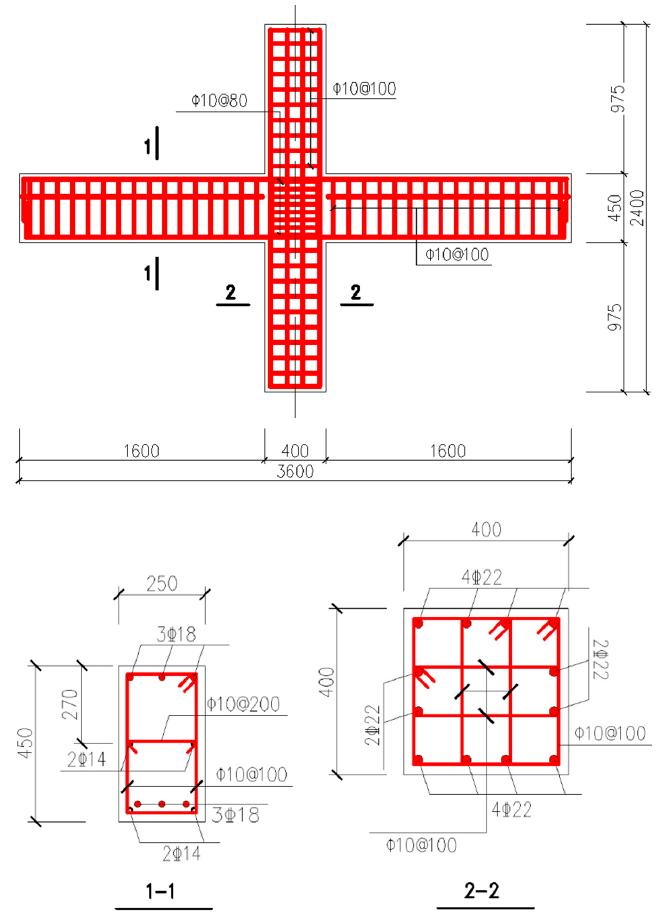
Figure 2. Reinforcement diagrams of the cast-in-place joint (unit: mm).